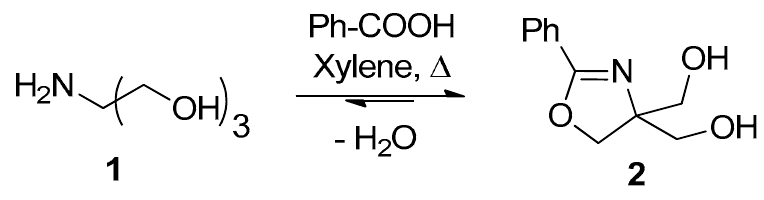
Figure 1. 1 H- 13 C Heteronuclear 2D spectrum (in CD 3 OD) of compound 2 .